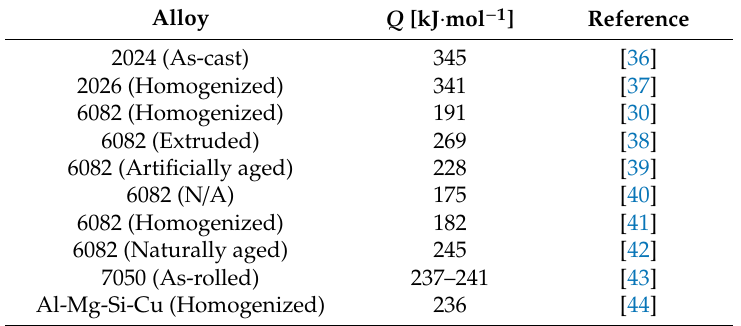
Table 3. Values of hot deformation activation energy calculated for various aluminium